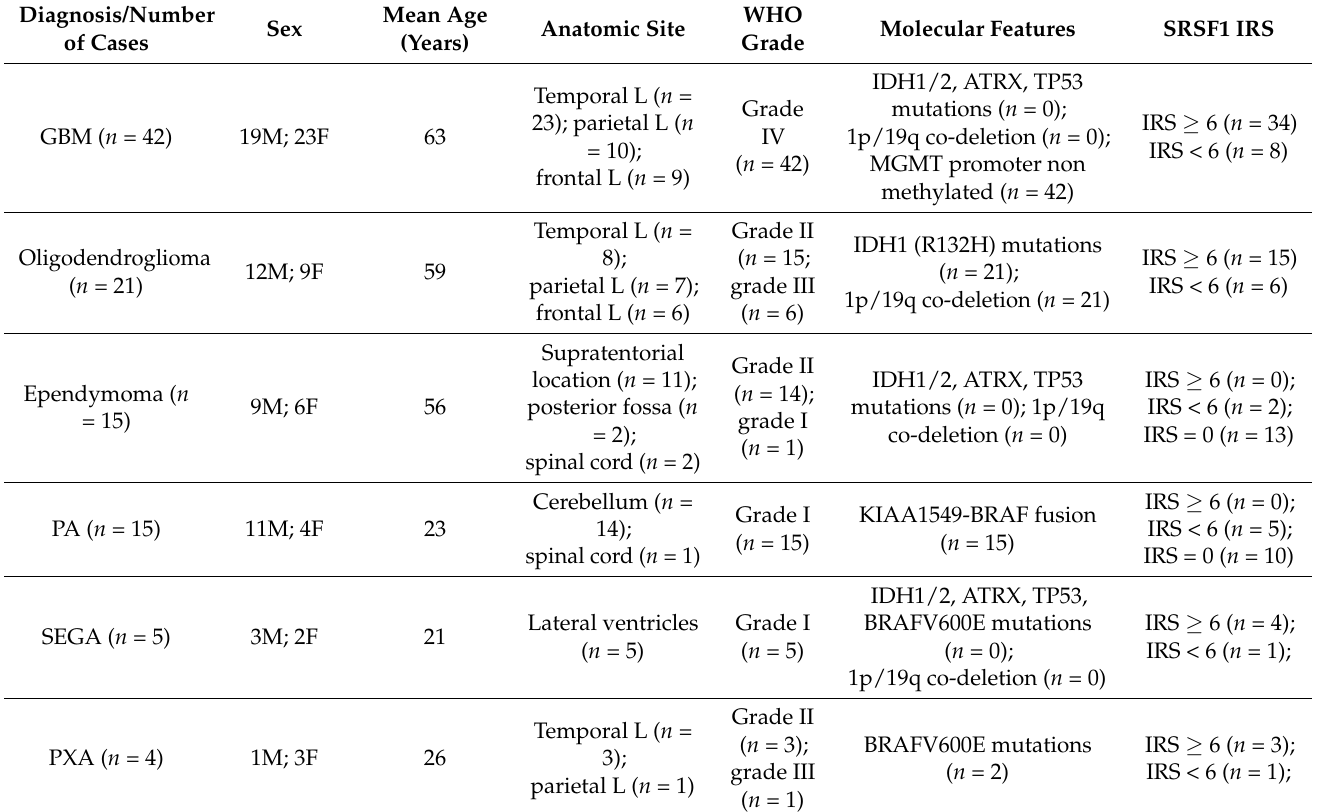
Table 1. Summary of the clinico-pathological, molecular and immunohistochemical